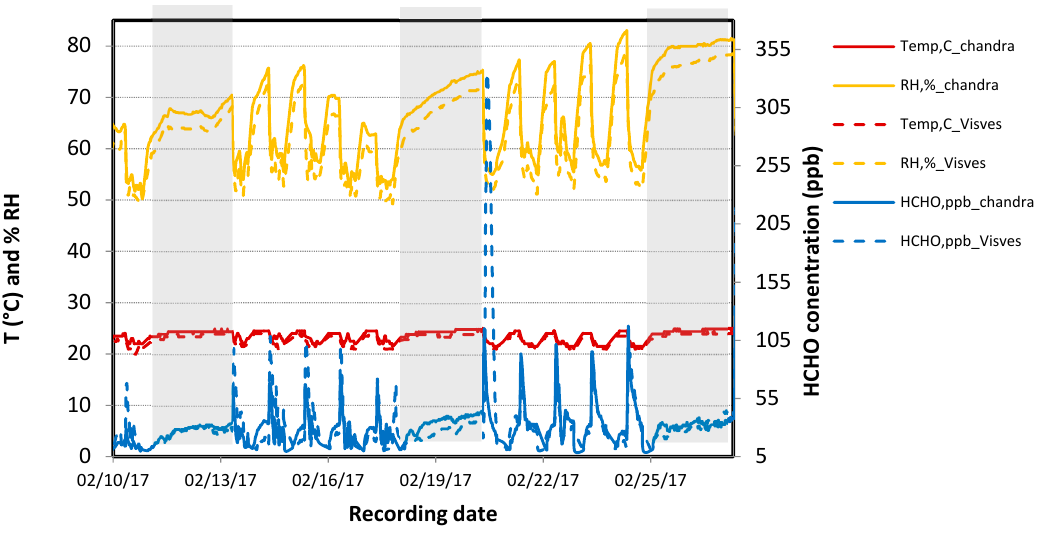
Figure 13. Continuous monitoring in Visvesvaraya and Chandrasekhar meeting rooms from 10 to 27 February. Weekends are highlighted in grey.